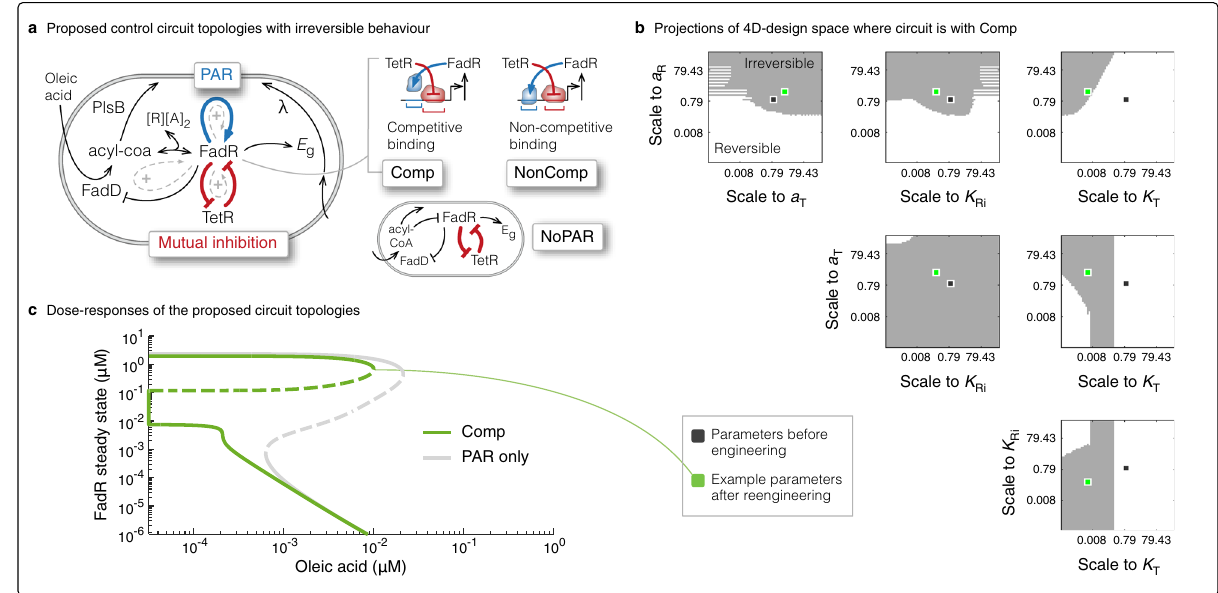
Fig. 3 Augmenting with a positive feedback allows irreversible behaviour. a Schematic of the control circuit with PAR (blue arrow) that was shown to deplete FadR in Fig. 2b, which we now model augmented with an addition positive feedback loop through mutual inhibition of FadR and TetR (red arrows), that we hypothesise will keep FadR expression off (see text for derivation of hypothesis). In the model of this proposed circuit, we consider three possible circuit topologies: where there is no PAR (NoPAR), and where the operator sites of FadR and TetR can be con fi gured so both transcription factors bind competitively (Comp) or non-competitively (NonComp). b Plots showing projections of the parameter design space onto every pairwise plane of parameters, for the circuit Comp, the circuit we found has largest design space with irreversible behaviour of the three circuits. We varied parameters a R , − 3 and 10 3 times their nominal values, and determined irreversible behaviour if we found more than one steady state. a K K T , Ri , T simultaneously between 10 The dark spot indicates the nominal parameter set, which did not give an irreversible switch, and the green spot indicates an example parameter regime (( a R , a T , K Ri , K T ) = (0.45, 0.26, 38.5, 22.3)) that makes switch irreversible (see Supplementary Table 4 for proposed scaling to parameters). c Plot of the dose-response curves showing the irreversible switch behaviour of the Comp circuit (green curve), for the example parameter regime (green dot in b ). We show comparison to the circuit with the same parameters but with only PAR, as in Fig. 1a.